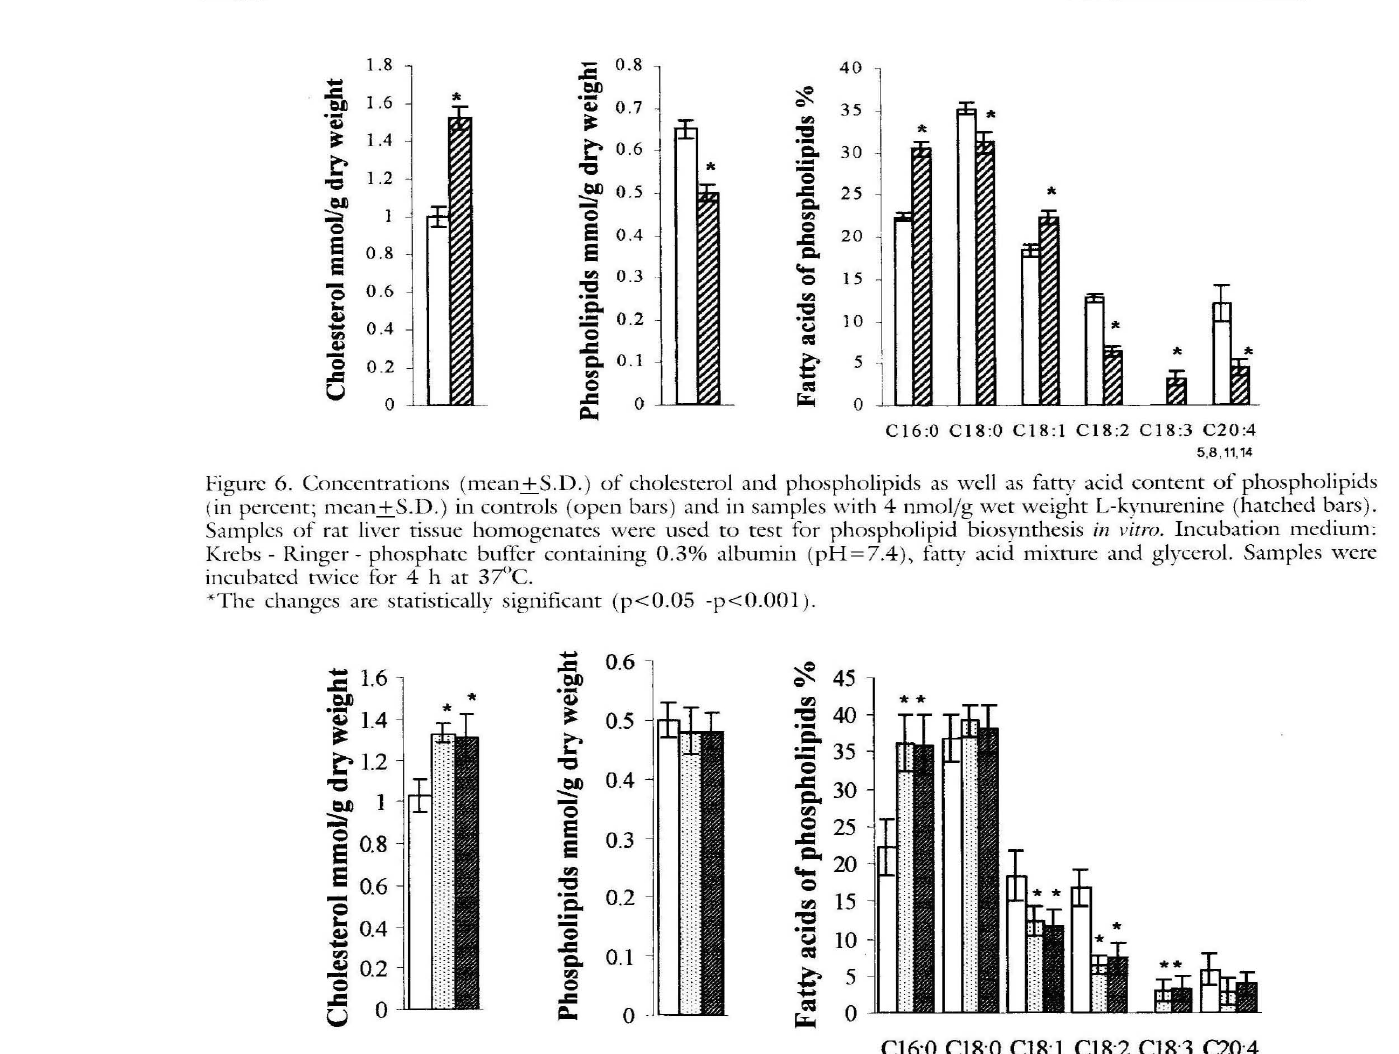
Figure 7. Concentrations (mean±S.D. ) of cholesterol and phospholipids as well as fatty acid content of phospholipids (in percent; mean±S.D.) in controls (open bars I and in "lmples \\'ith 5 pmoljg wet weight D-neopterin (dotted bars) and in san'lples with 30 pmoljg wet weight D-neoptcrin I h'ltched bars). Samples of rat liver tissue homogenates were used to test fix phospholipid biosvnthesis in I'if/n. Incub.nion medium: Krebs - Ringer - phosphate bufTer containing 0.3% albumin (pH=7.4), Ent)' acid mixture and gh-cerol. Samples \"cre incubated twice for 4 h at 37°C. 'The changes are statistically significant (p<O.Ol